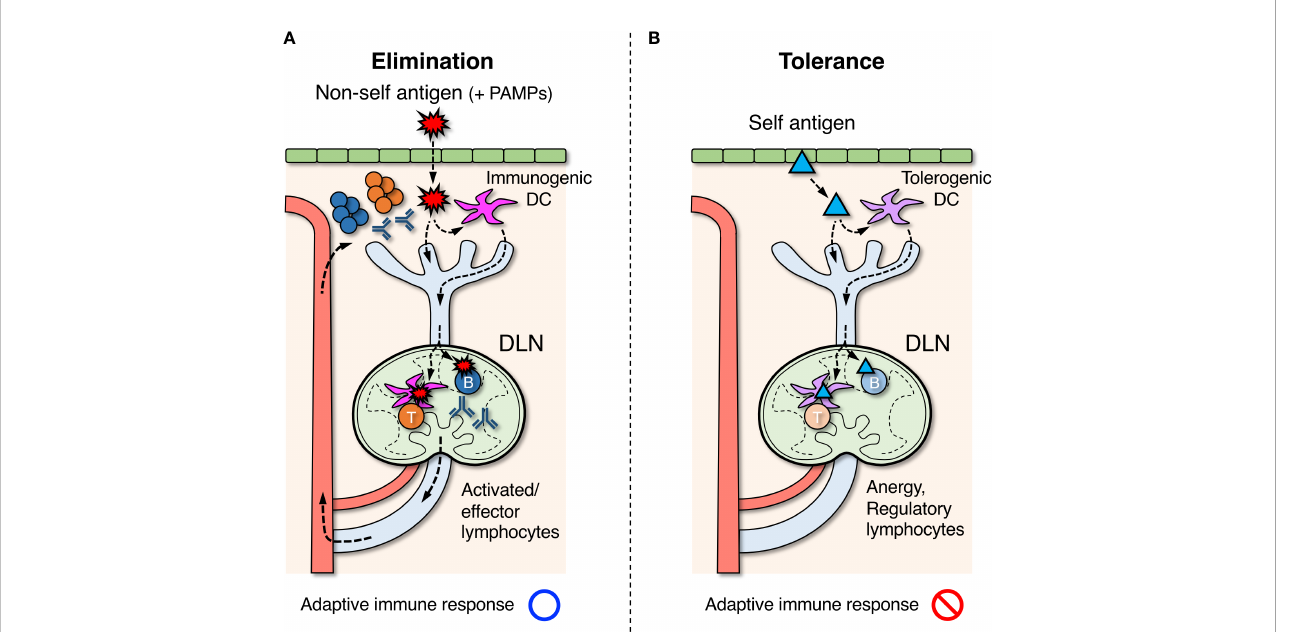
FIGURE 1 Roles of draining lymph nodes (DLNs) in the induction of adaptive immune response, elimination of foreign antigens, and tolerance to self-antigens. (A) Foreign antigens ( ) derived from microorganisms or pathogens that entered the body are taken up by dendritic cells (DCs) in peripheral tissues. If DCs are simultaneously stimulated by pathogen-associated molecular patterns (PAMPs), they acquire immunogenic property and migrate to DLNs via the lymphatic vessel. In DLNs, DCs further migrate into the paracortex to present antigens for activating T cells. Some of the antigens are also transported directly by lymph fl ow to the follicles of DLNs, and B cells that recognize them are activated. Activated lymphocytes are differentiated into effector cells and exit LNs via the efferent lymphatic vessel, returning to the blood circulation. They eventually in fi ltrate the site of in fl ammation and eliminate foreign antigens. (B) Self antigens ( ▴ ) in peripheral tissues are constitutively engulfed by DCs and transported to DLNs. In the absence of PAMP stimuli, DCs acquire tolerogenic property and induce unresponsive or regulatory function in self-reactive T cells in DLNs. Similarly, regulatory B cells are thought to be induced when self-reactive B cells recognize the same